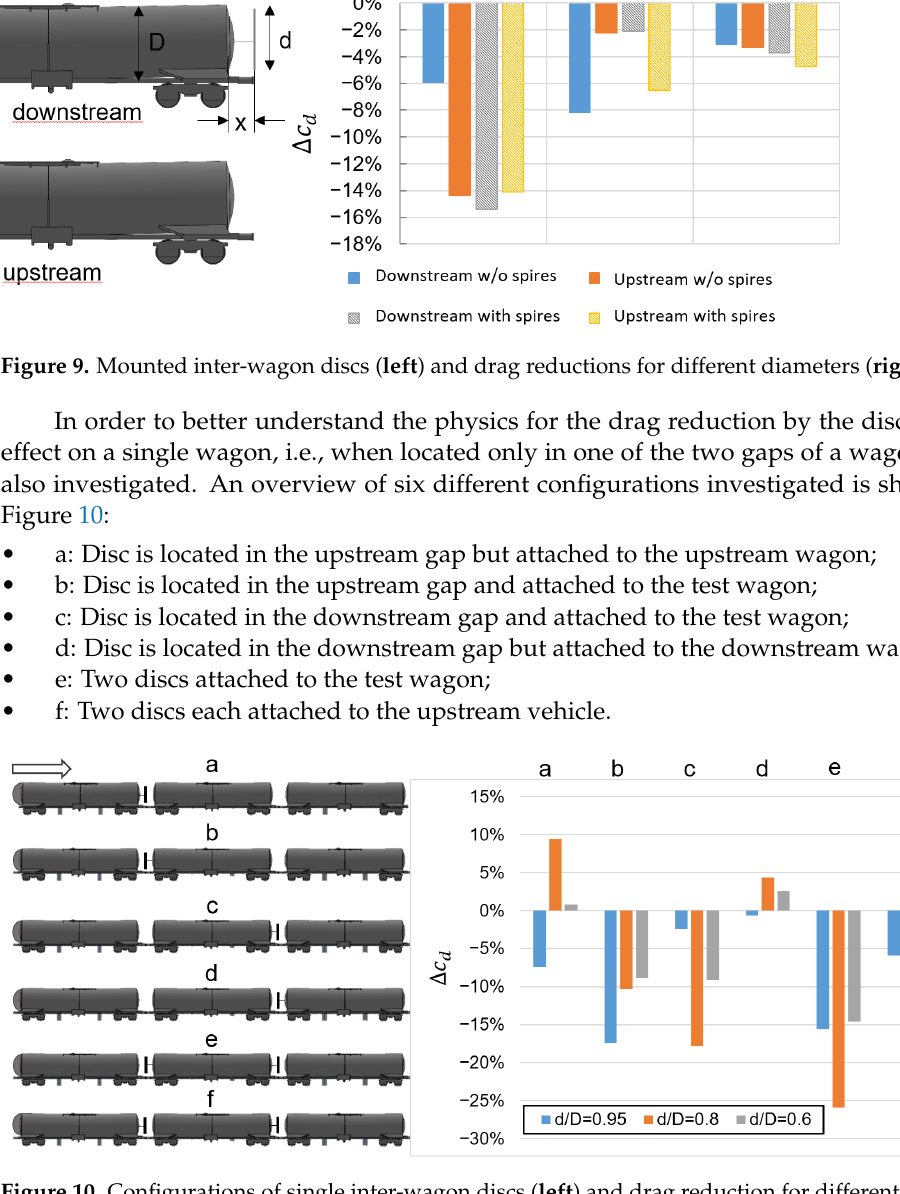
Figure 10. Configurations of single inter-wagon discs ( left ) and drag reduction for different configu- rations ( right